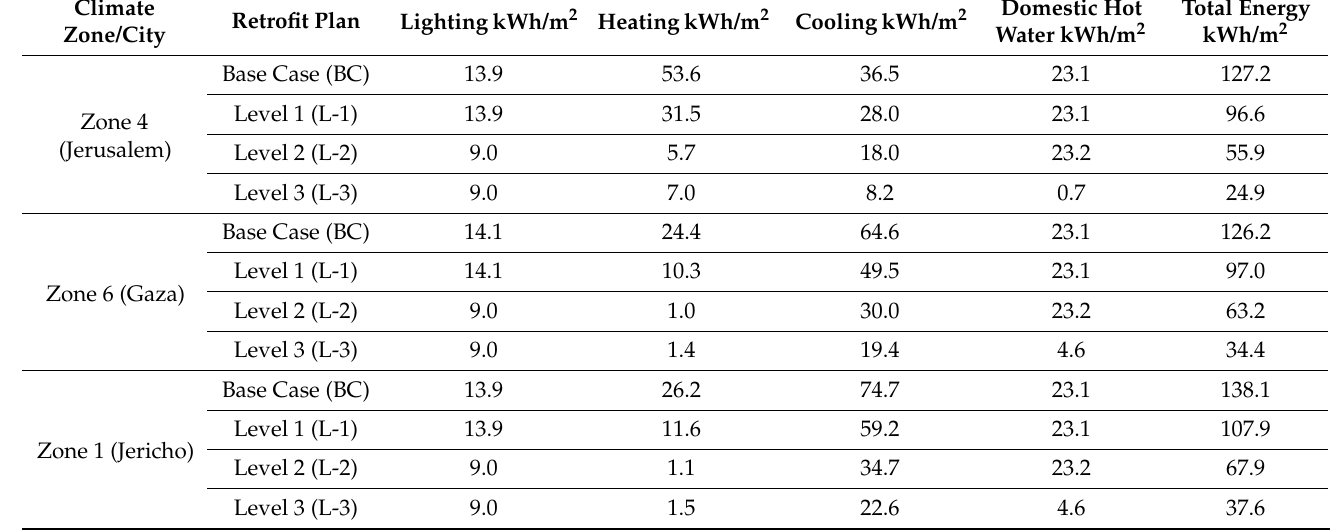
Table 2. Results from the simulation for energy consumption for lighting, heating, cooling, and domestic hot water, comparing the base case scenario with the three-level retrofit plans for buildings with four units per floor area. Climate Retrofit Zone/City